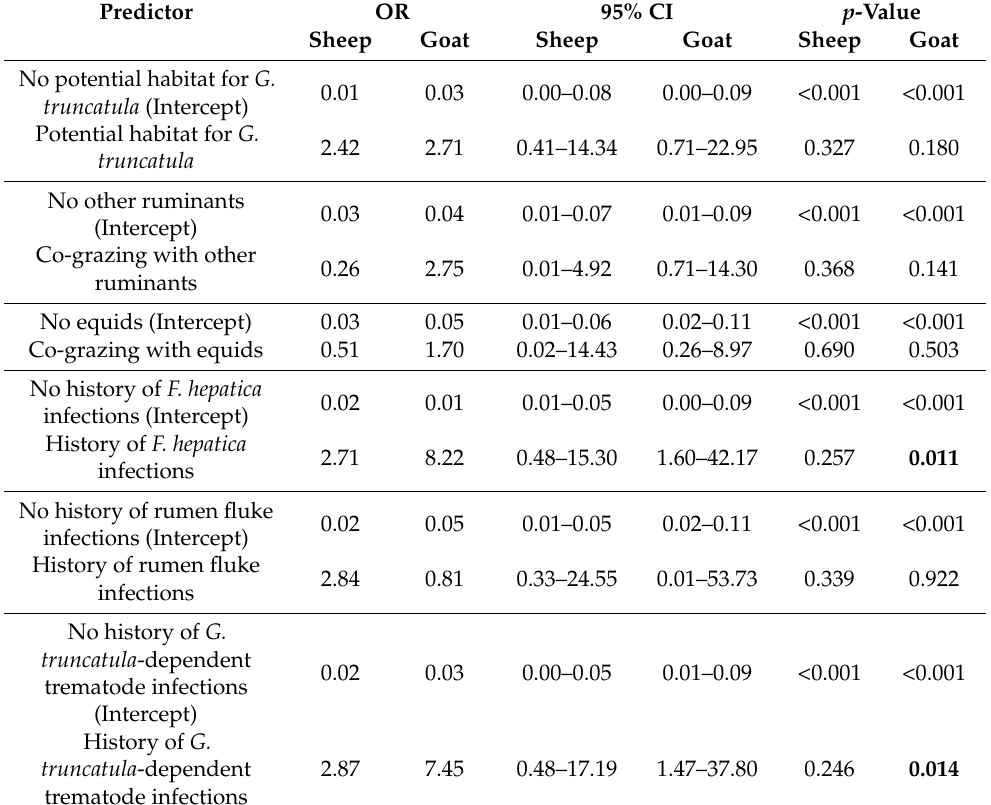
Table 8. Results of simple logistic regressions: predictors for patent F. hepatica -infections on sheep and goat